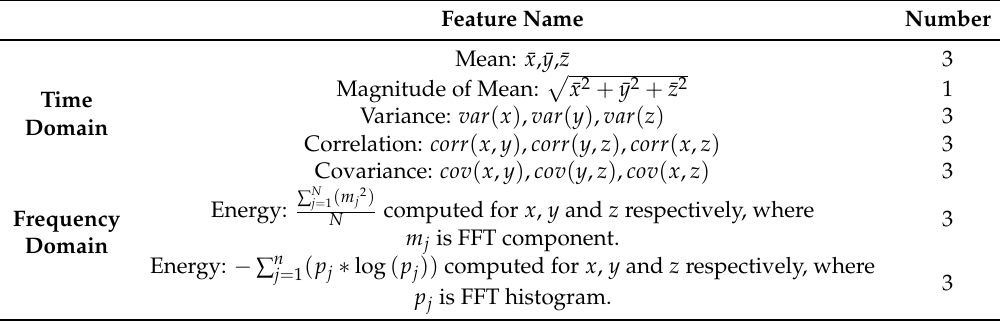
Table 1. Implemented features on the learner context collector